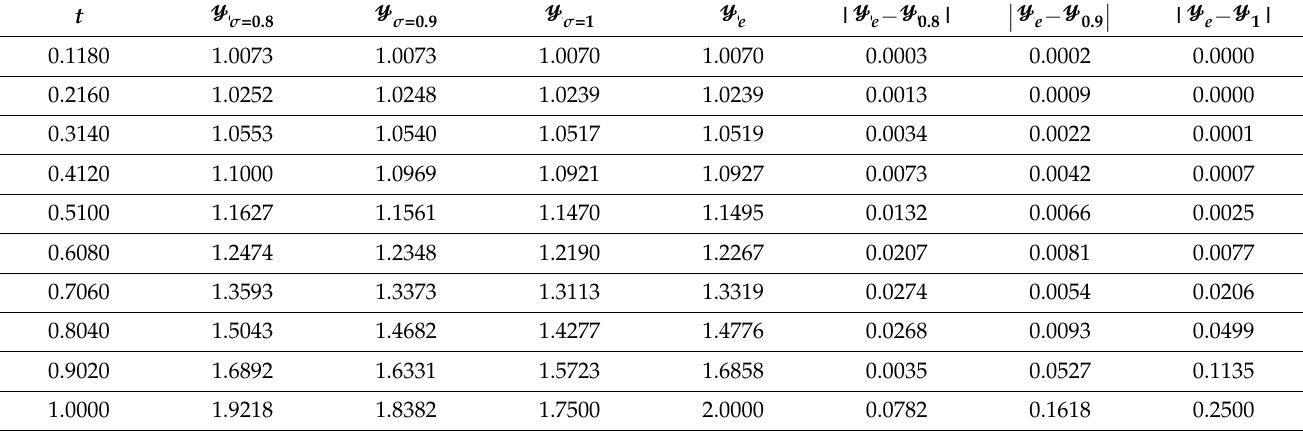
Table 1. Values of the approximate and exact solutions of Equation (19) at di ff erent values of 𝓉 .